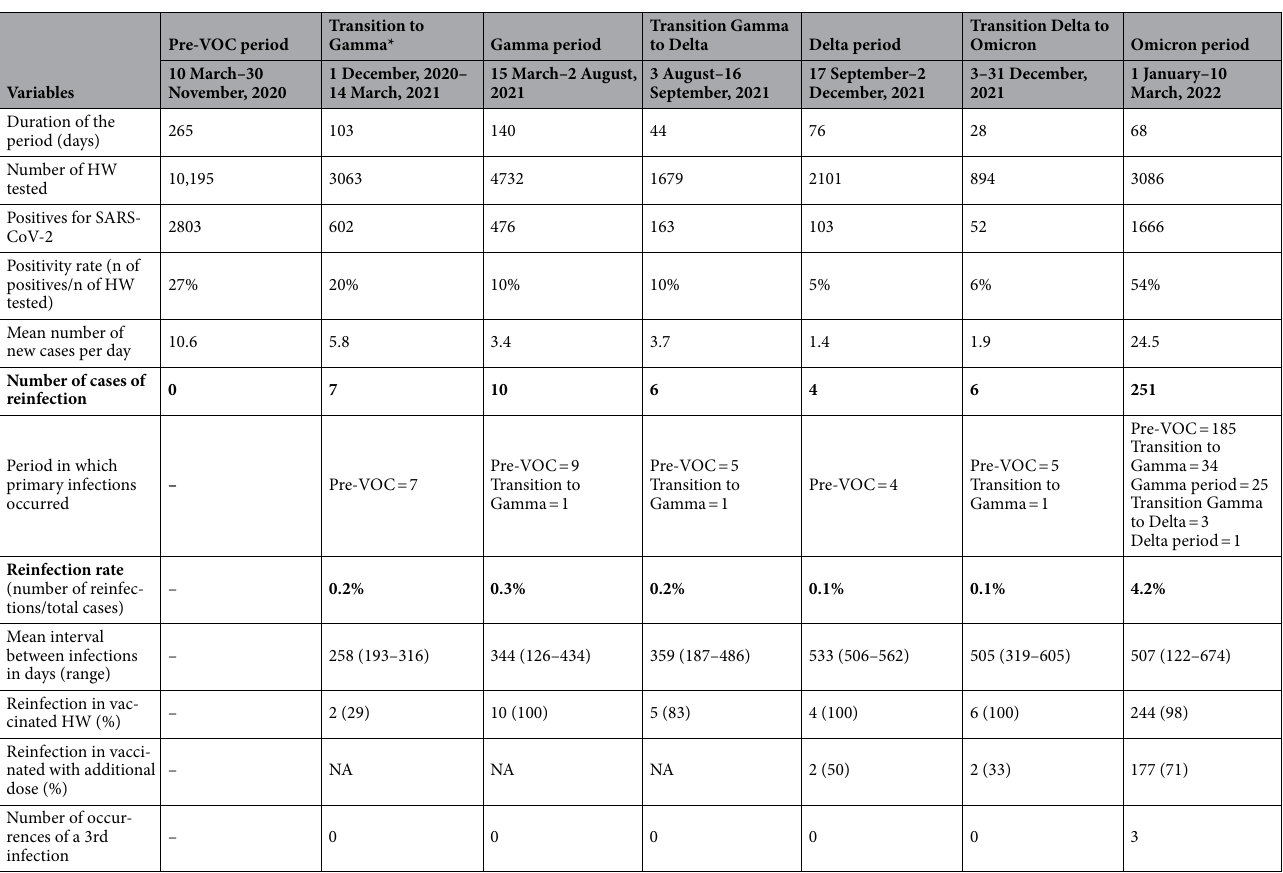
Table 2. Distribution of COVID-19 cases in healthcare workers (HW) of Hospital das Clínicas (University of São Paulo) according to the emergence of variants of concern (VOCs) during 2 years of the pandemic